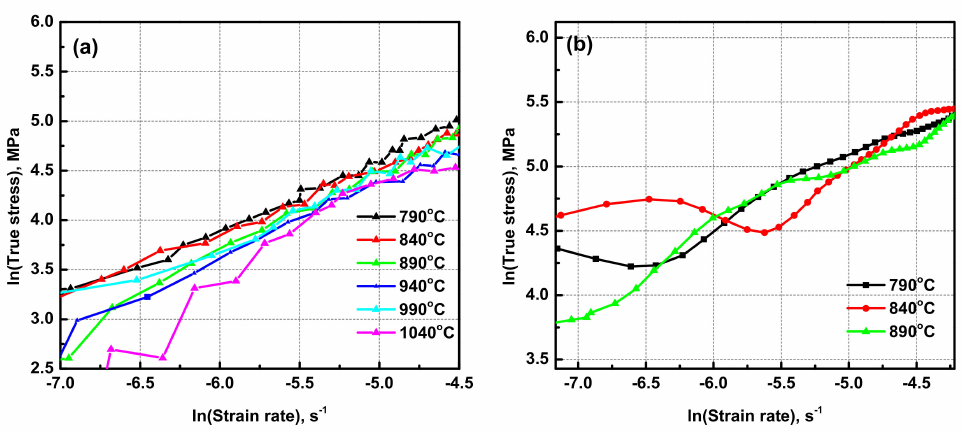
Figure 7. Fluctuation of strain rate sensitivity, m, at strain rates of 1 s − 1 ( a ) and 10 s − 1 ( b